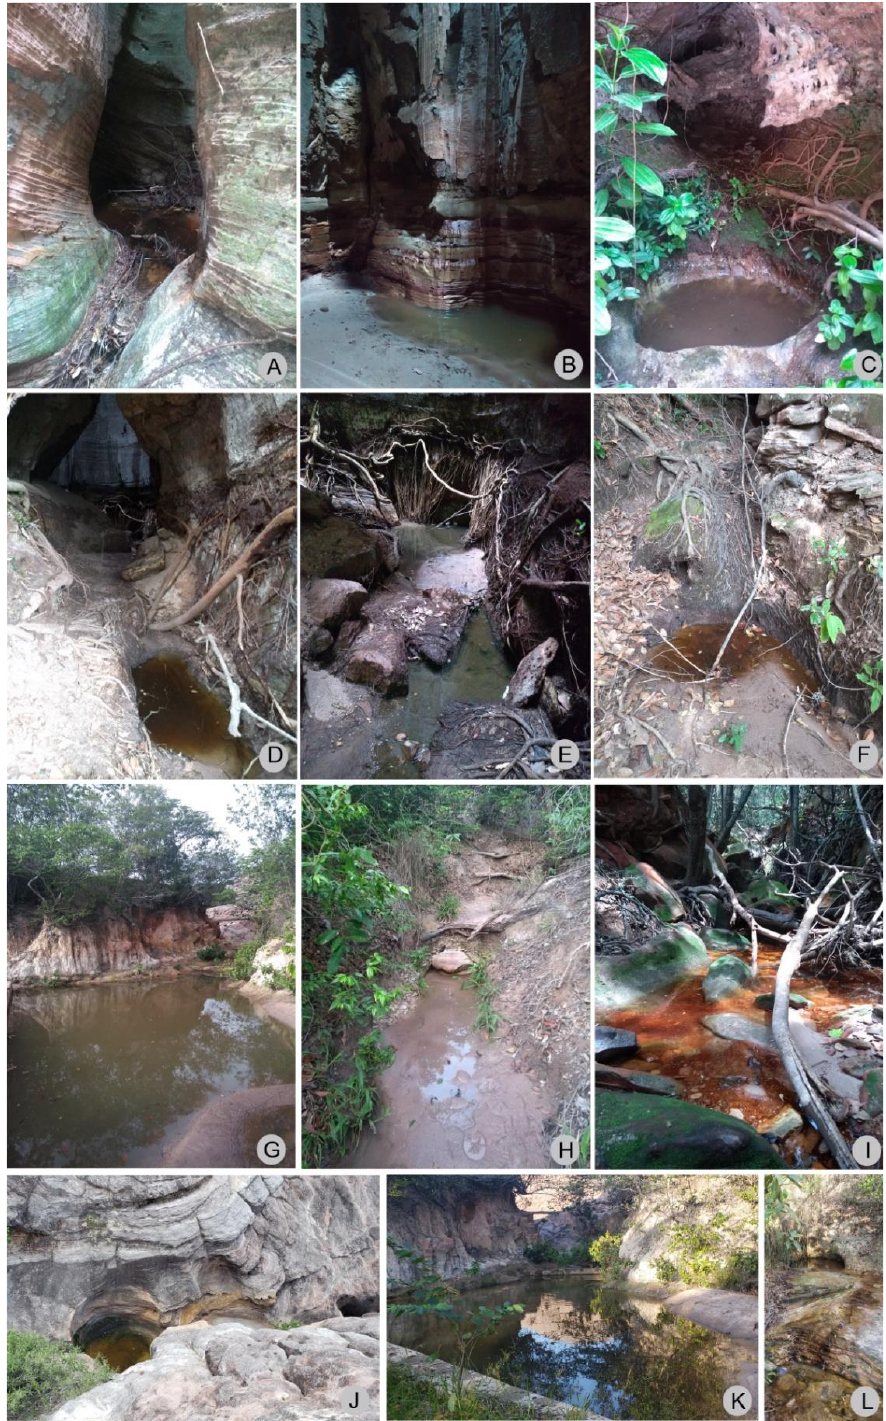
Figure 12. Photographs of the localities where P. nieseri was collected in Serra das Confusões National Park, Piauí state, Brazil. ( A – C , G – L ). Caracol municipality. ( D – F ). Guaribas municipality. ( A – C ). Puddles in the Catedral; 09°08 ′ 15.6 ″ S, 43°35 ′ 50.6 ″ W. ( D – F ). Puddles; 09°08 ′ 24.9 ″ S, 43°33 ′ 41.0 ″ W. ( G ). Swamp, between the lookout Janela do Sertão and the cemetery; 09°13 ′ 09.1 ″ S, 43°29 ′ 24.8 ″ W. ( H ). Stream, between the lookout Janela do Sertão and the cemetery; 09°12 ′ 07.5 ″ S, 43°29 ′ 24.6 ″ W. ( I ). Stream; 09°13 ′ 16.6 ″ S, 43°29 ′ 43.5 ″ W. ( J ). Puddle in the Cores da Caatinga trail; 09°12 ′ 17.7 ″ S, 43°28 ′ 21.9 ″ W. ( K , L ). Puddles beside the road, near the cemetery, 09°13 ′ 06.5 ″ S, 43°29 ′ 25.3 ″ W.